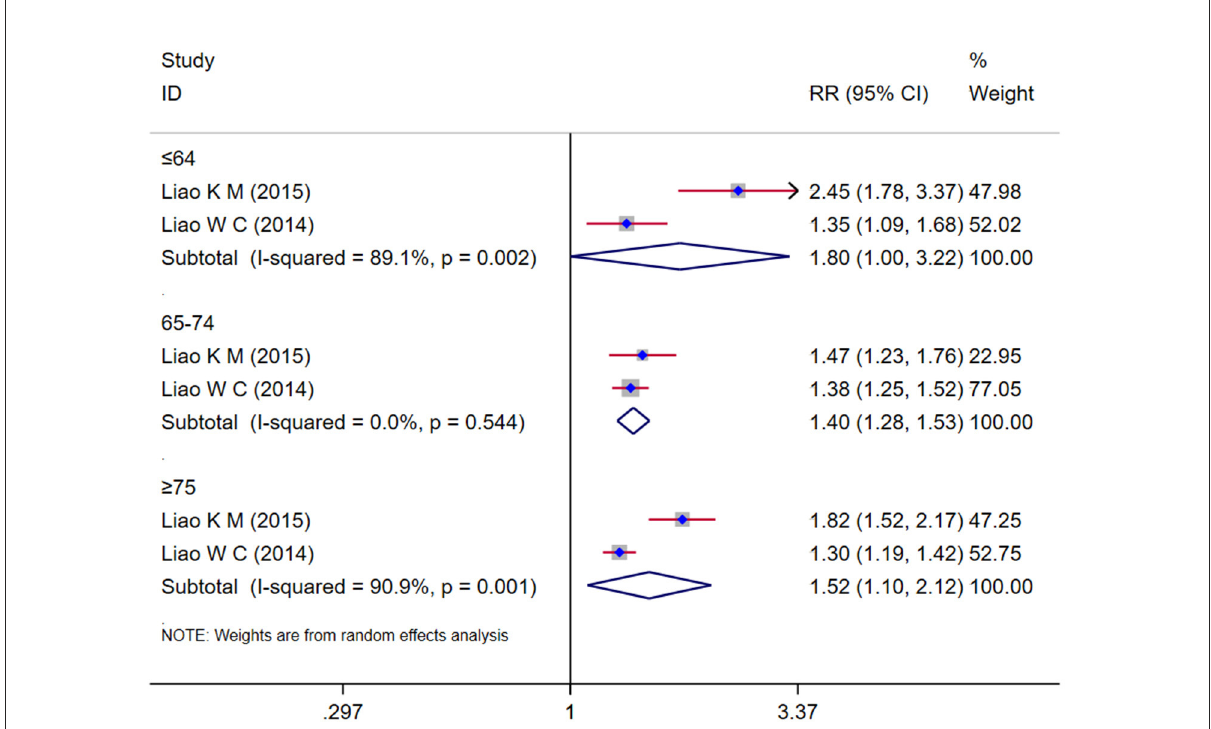
FIGURE4 Subgroup analysis by age group evaluating the risk of dementia in COPD patients.